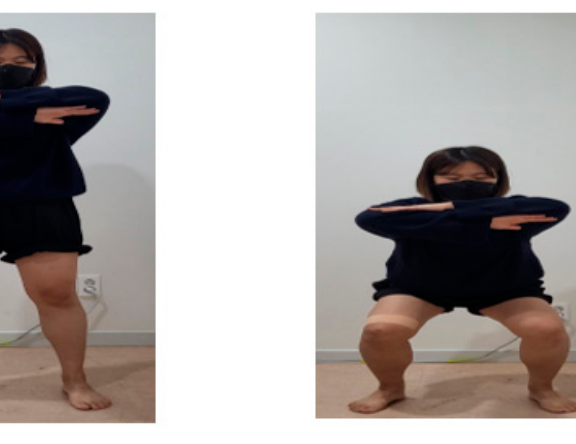
Figure 4. Sham Kinesio taping with squat exercise.